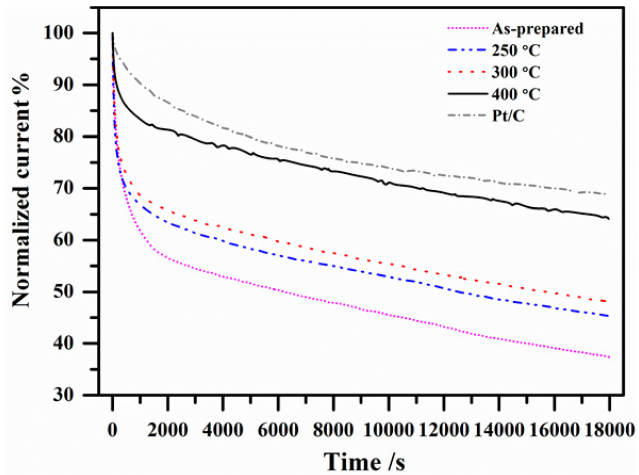
Figure 7. Chronoamperometric response (percentage of current retained vs. operation time) of 20 wt. % CoS/C after annealed at different temperature and 20 wt. % Pt/C (E-TEK)